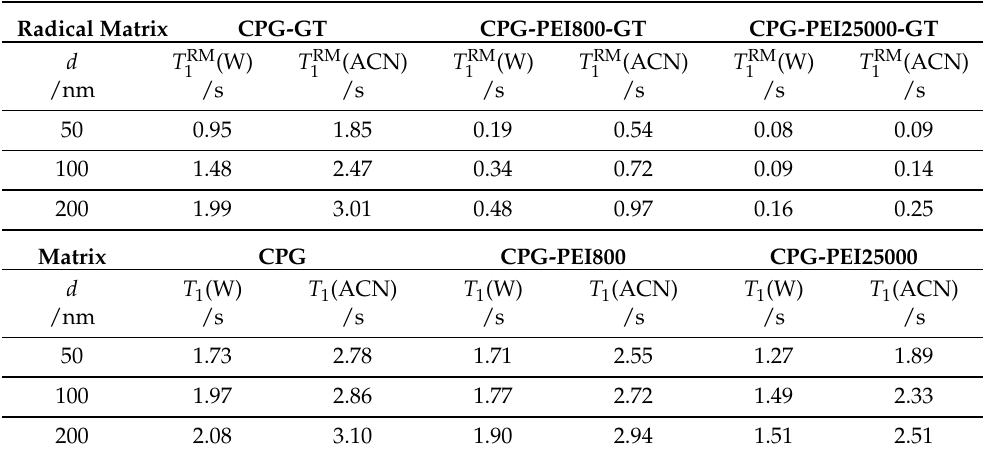
Table 2 lists T 1 values of acetonitrile and water in static contact with the radical matrices and with the plane matrix without immobilized radicals, CPG, CPG-PEI800, and CPG-PEI25000 that were used to study the relaxation behavior dependent on the pore size of CPGs and the size of the PEI-linker. Table 2. Longitudinal relaxation times T 1 of water (W) and acetonitrile (ACN) in static contact with CPGs with pore size d of 50, 100 and 200 nm at 1 Tesla and 28.5 ◦ C. T RM indicates values obtained 1 in contact with the radical matrix, T 1 indicates values in contact with PEI-grafted CPG matrices without radicals. Radical Matrix CPG-GT CPG-PEI800-GT